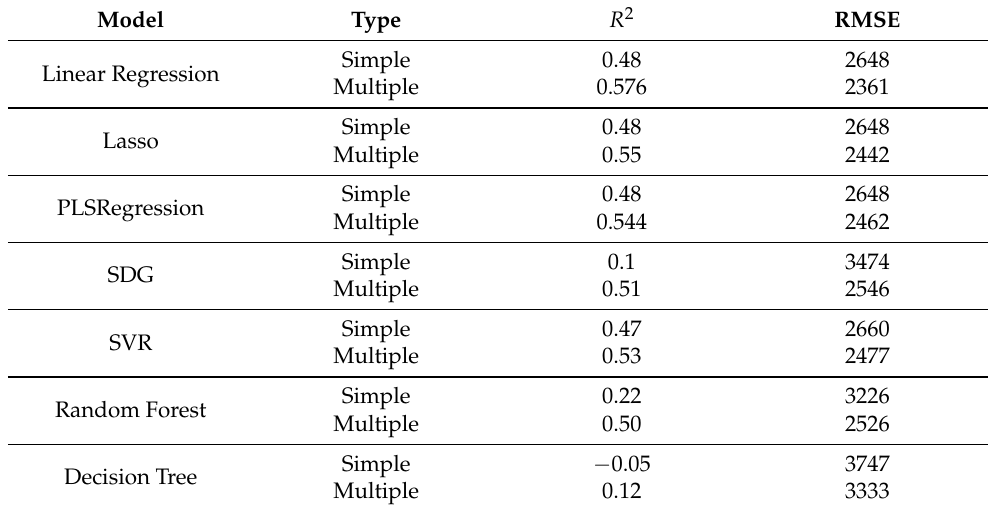
Figure 16. Regression models. Table 3. Summary of regression